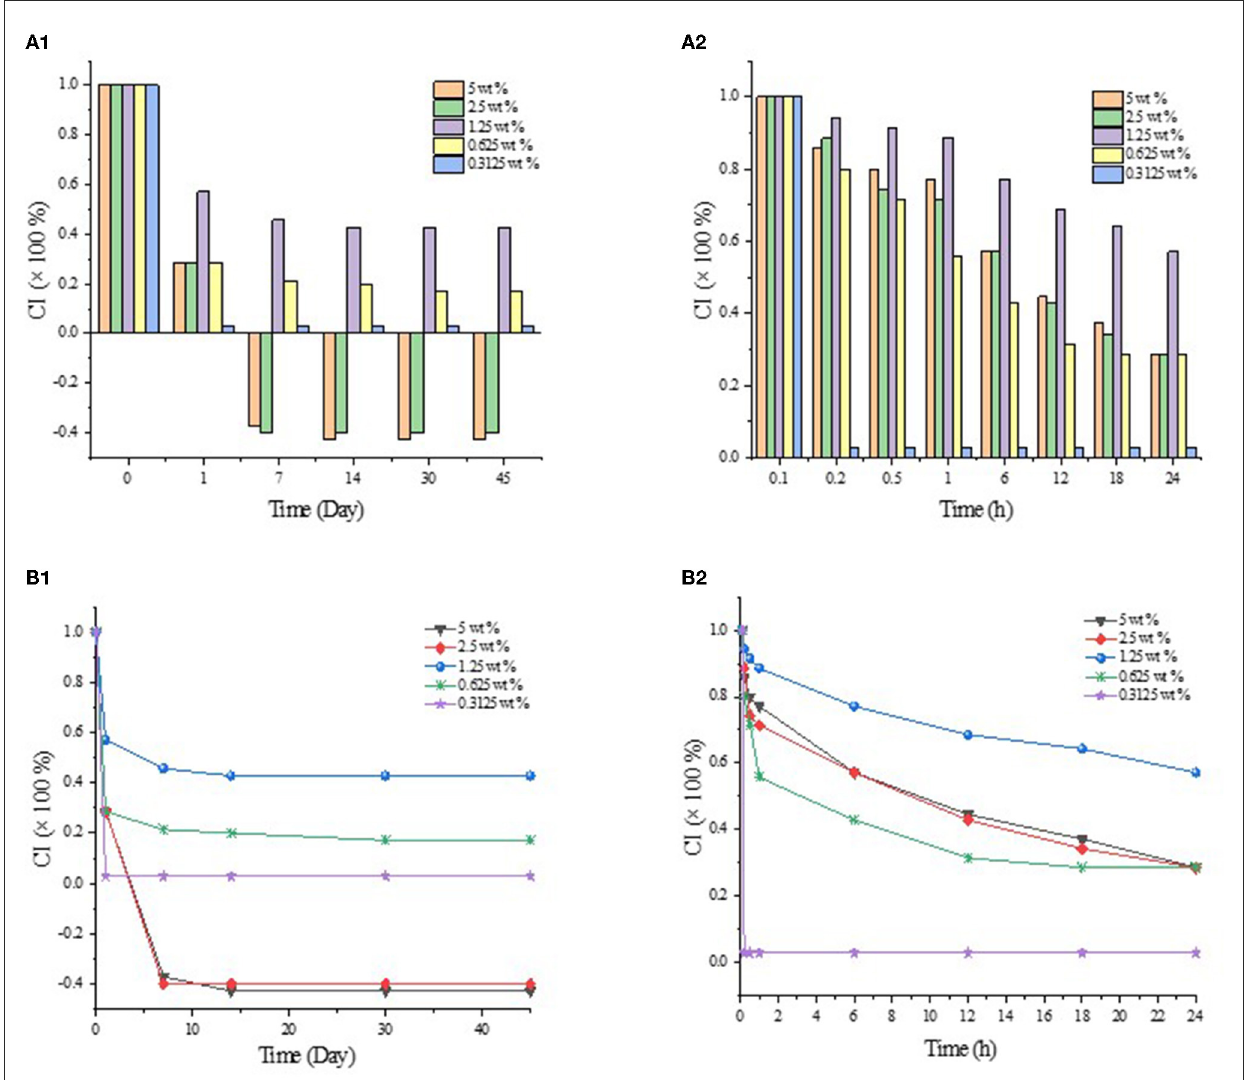
FIGURE2 CI values of GO/ β -CD emulsion in different storage times. (A1) and (B1) for CI values at 45 d, (A2) and (B2) for CI values at